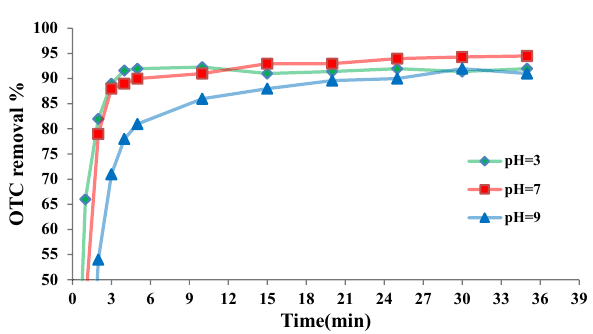
Fig. 7 The effect of pH on ZnO with time on the removal efficiency of OTC (OTC conc. = 50 mg/l, ZnO = 100 mg/l, ozone generation rate = 1.38 mg/s, at room temp.)